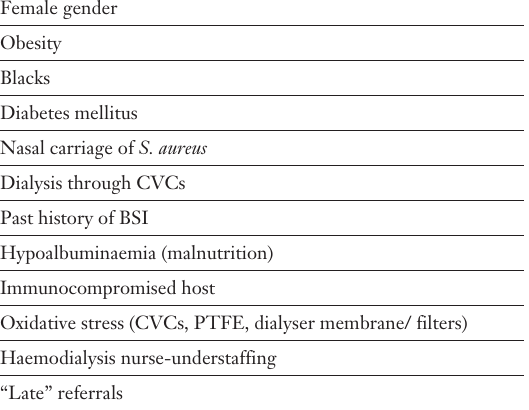
Predisposing factors for HD catheter-re- lated blood stream infections [3,